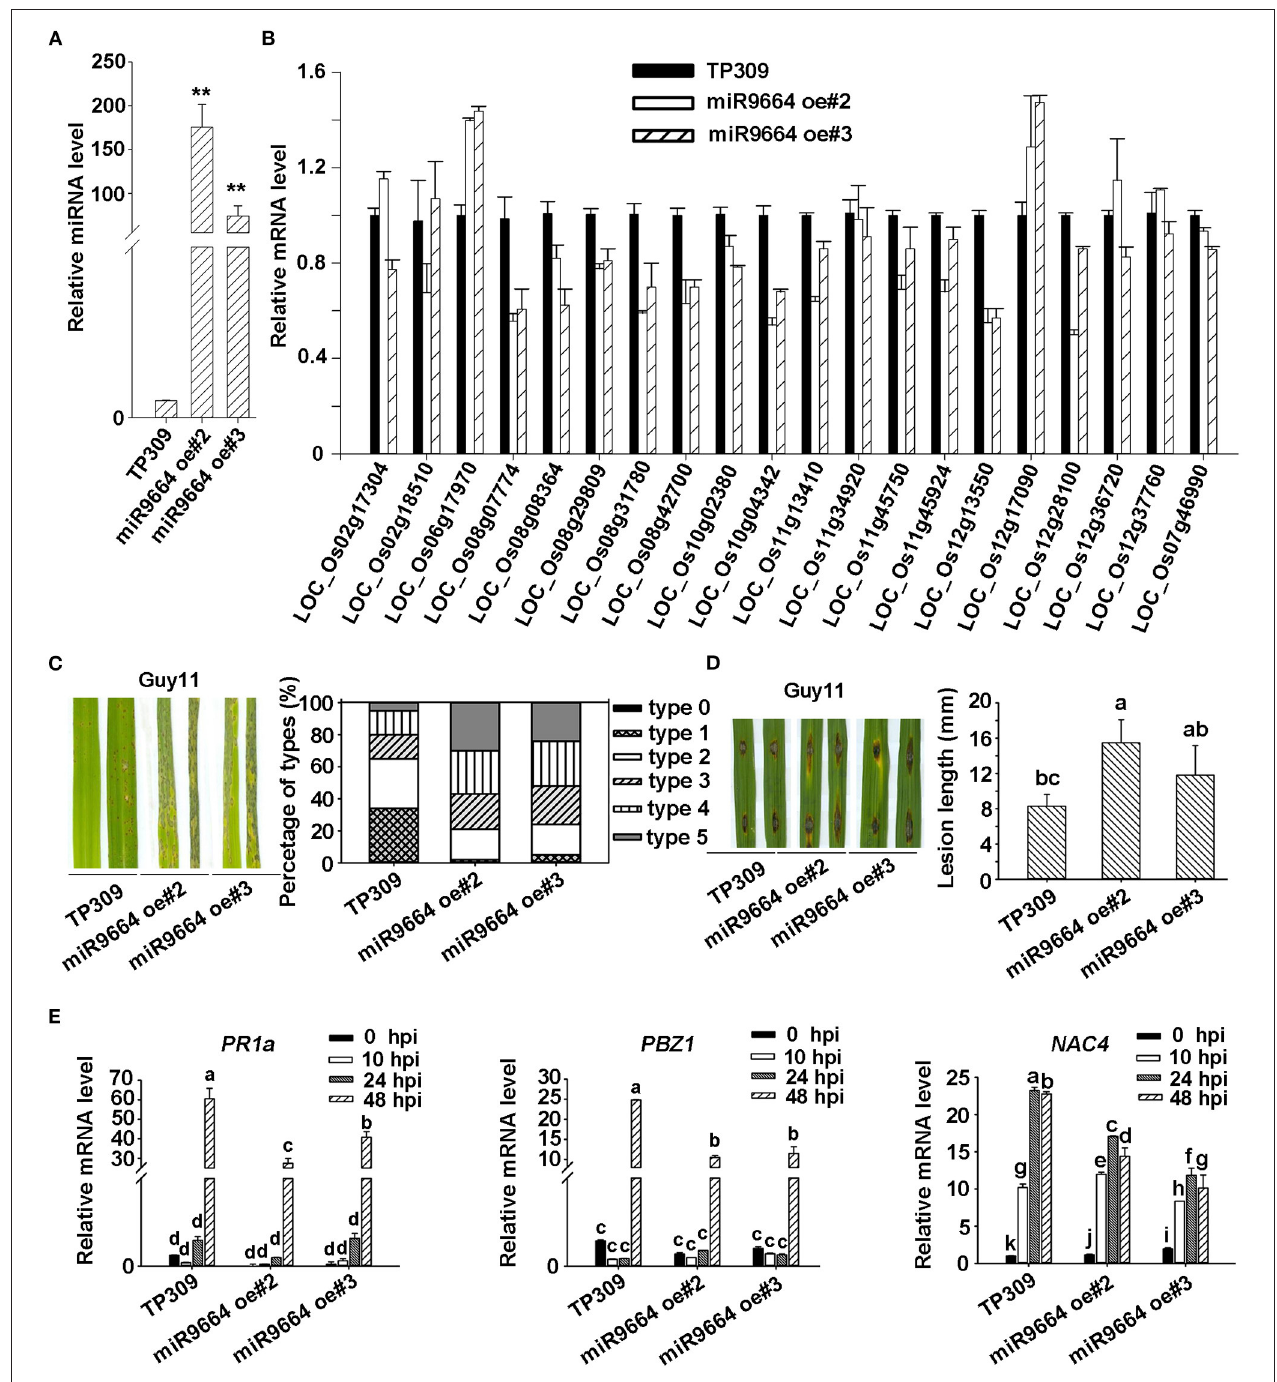
FIGURE 5 | miR9664-oe plants enhanced susceptibility to M. oryzae GUY11. (A) The relative expression level of miR9664 in the two miR9664-oe lines. The ** above the bars indicate significant differences ( P < 0.01). (B) The RNA expression level of 19 miR9664 predicted target genes in the two miR9664-oe lines, the non-target gene LOC_Os07g46990 was used as a control gene, qRT-PCR results were normalized with the Ubi reference gene. Similar results were obtained from the three independent biological experiments. (C) The blast resistance of miR9664-oe plants using spraying inoculation. Two inoculated leaves of each TP309, miR9664 oe#2, and miR9664 oe#3 are shown. The lesion types were obtained from the statistics of 80 diseased leaves at 5 dpi. (D) The blast resistance of miR9664-oe plants using punching inoculation. Two inoculated leaves of each TP309, miR9664 oe#2, and miR9664 oe#3 are shown. The lesion length was measured using a caliper. Error bars indicate SD ( n = 12), the letters above the bars indicate significant differences ( P < 0.01). (E) RNA expression levels of the defense-related gene PR1a , PBZ1, and NAC4 in miR9664-oe plants, qRT-PCR results were normalized with the Ubi reference gene, relative mRNA levels were normalized to those in the untreated control plants (0 hpi). Error bars represent the SD of three replicates ( n = 3). The letters above the bars indicate significant differences at a value of P < 0.01 as determined by a one-way ANOVA followed by a post-hoc Tukey HSD analysis. Similar results were obtained from the three independent biological experiments.